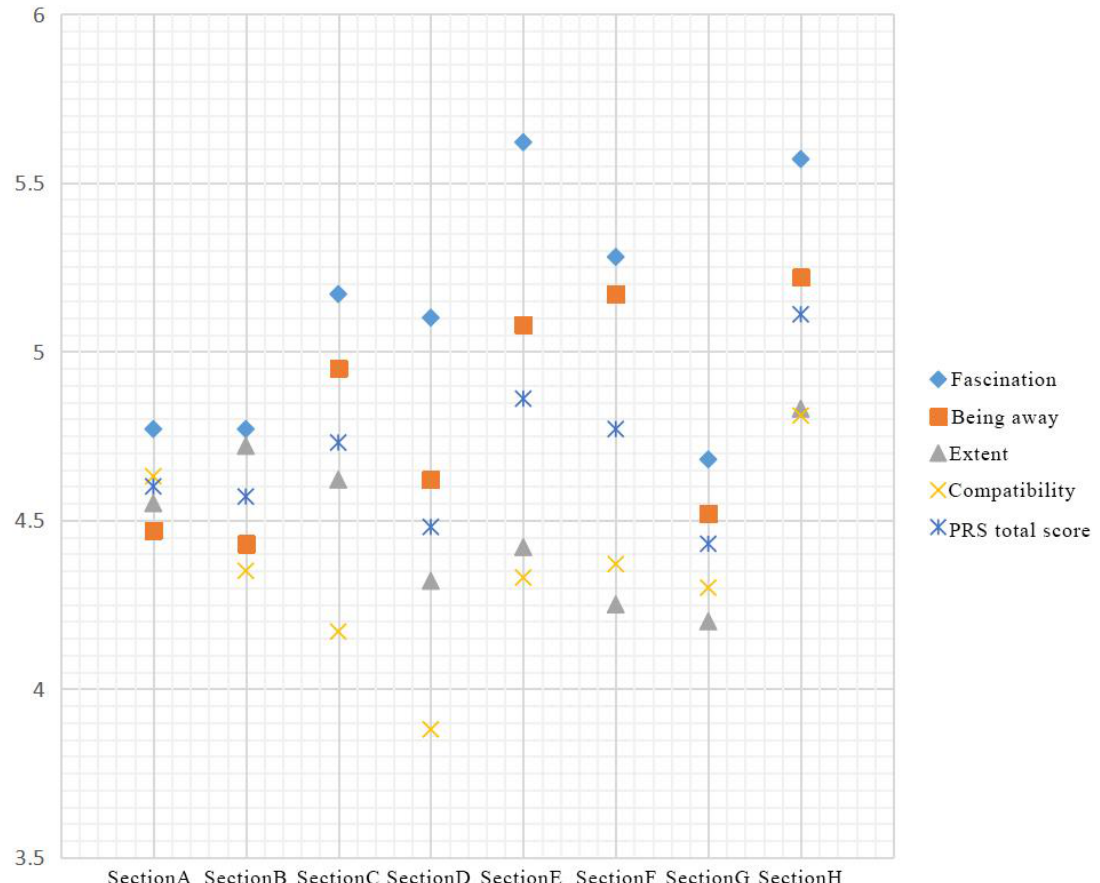
Figure 6. Statistical table of visual landscape perception recovery scale (PRS).